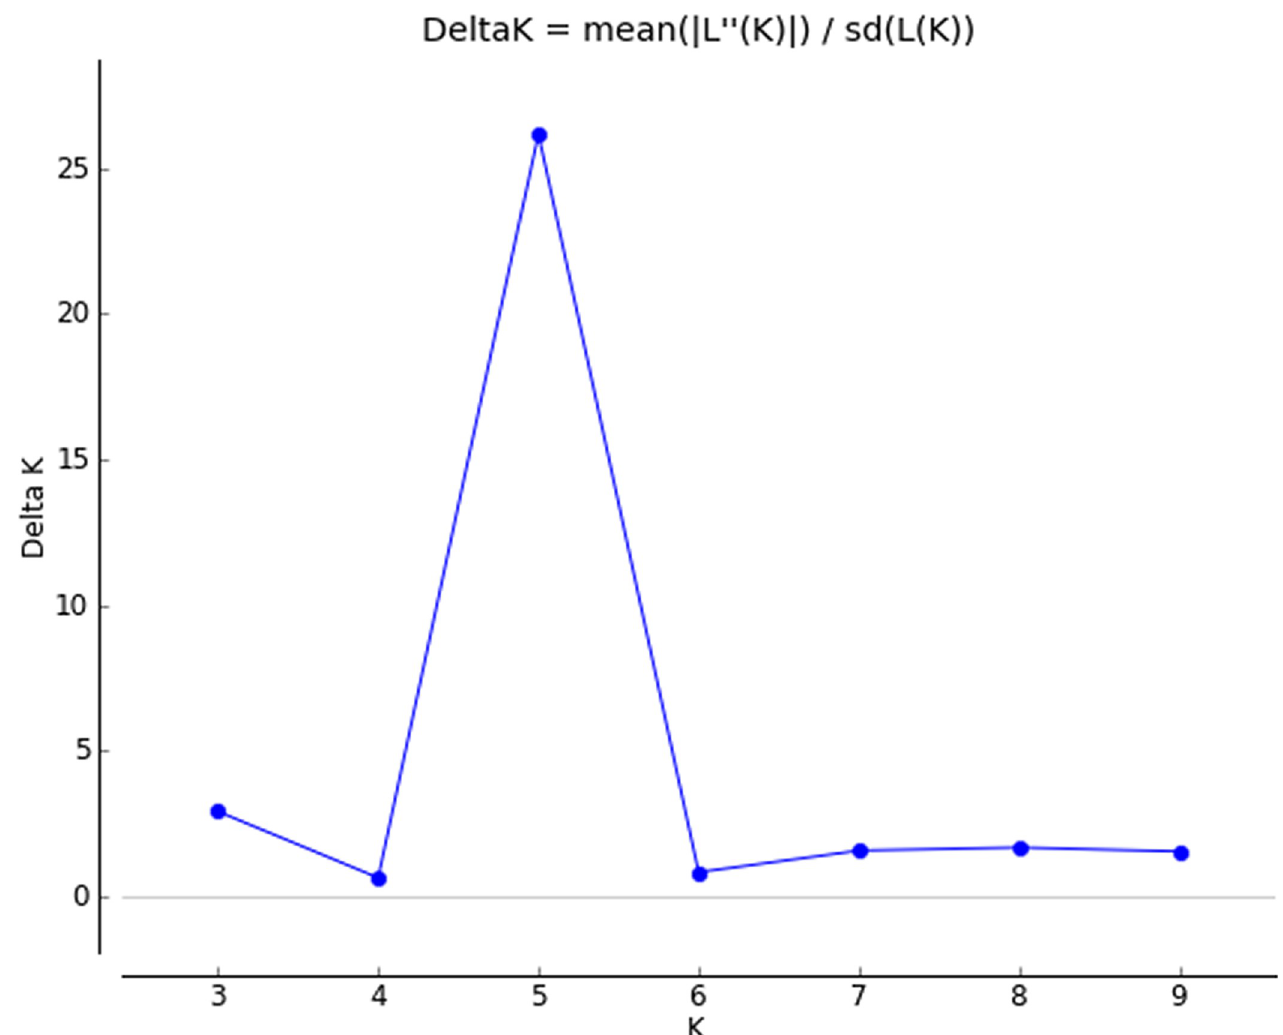
Fig 1. Population structure analysis in a diverse panel of smooth bromegrass genotypes ( Δ k was used to determine the optimum K value for population structure using the Bayesian clustering method).